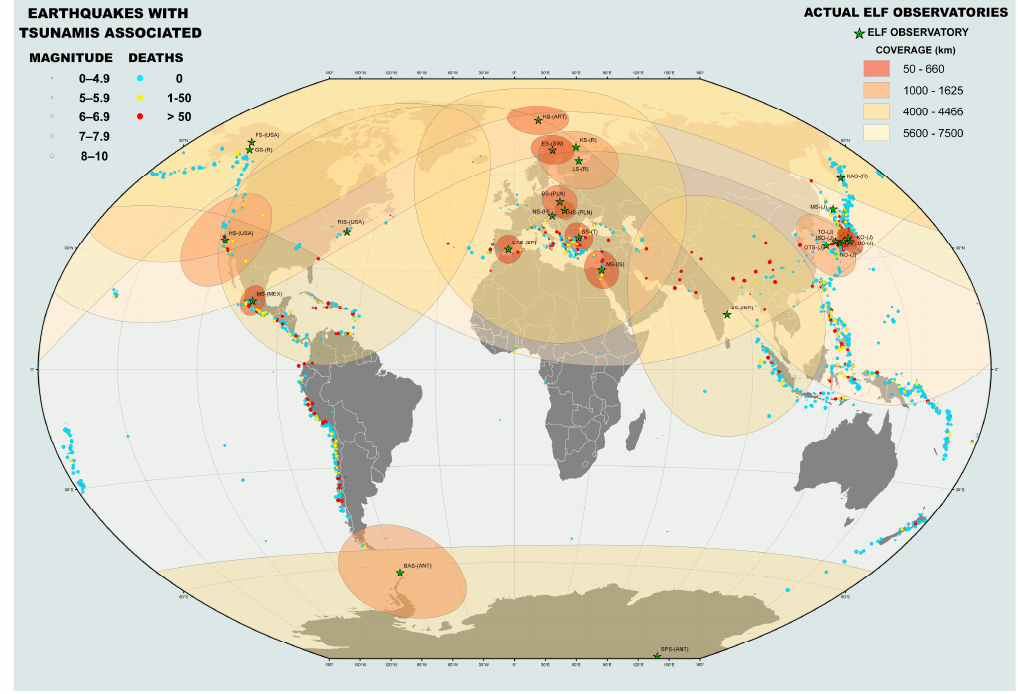
Figure 5. Tsunami risk alerts worldwide through ELF Sensors.